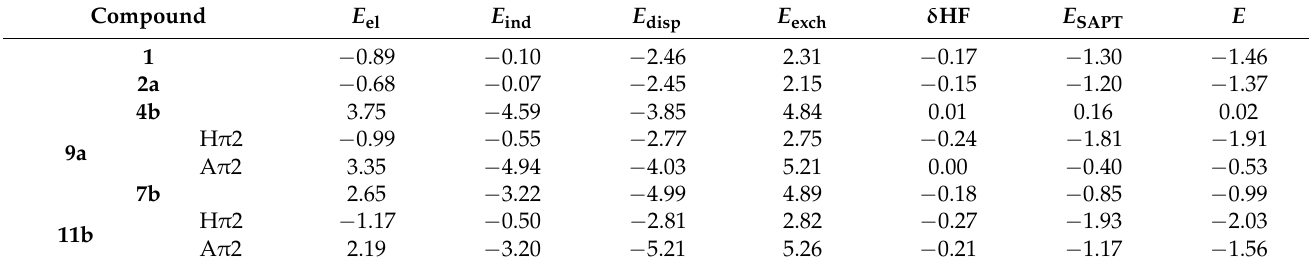
Table 3. DF-DFT-symmetry-adapted perturbation theory (SAPT) electrostatic, exchange, induction, dispersion and Hartree-Fock higher-order energy contributions ( E el , E exch , E ind , E disp and δ HF, respectively), SAPT interaction energy ( E SAPT ) and binding energies ( E ) of selected complexes. Energies in